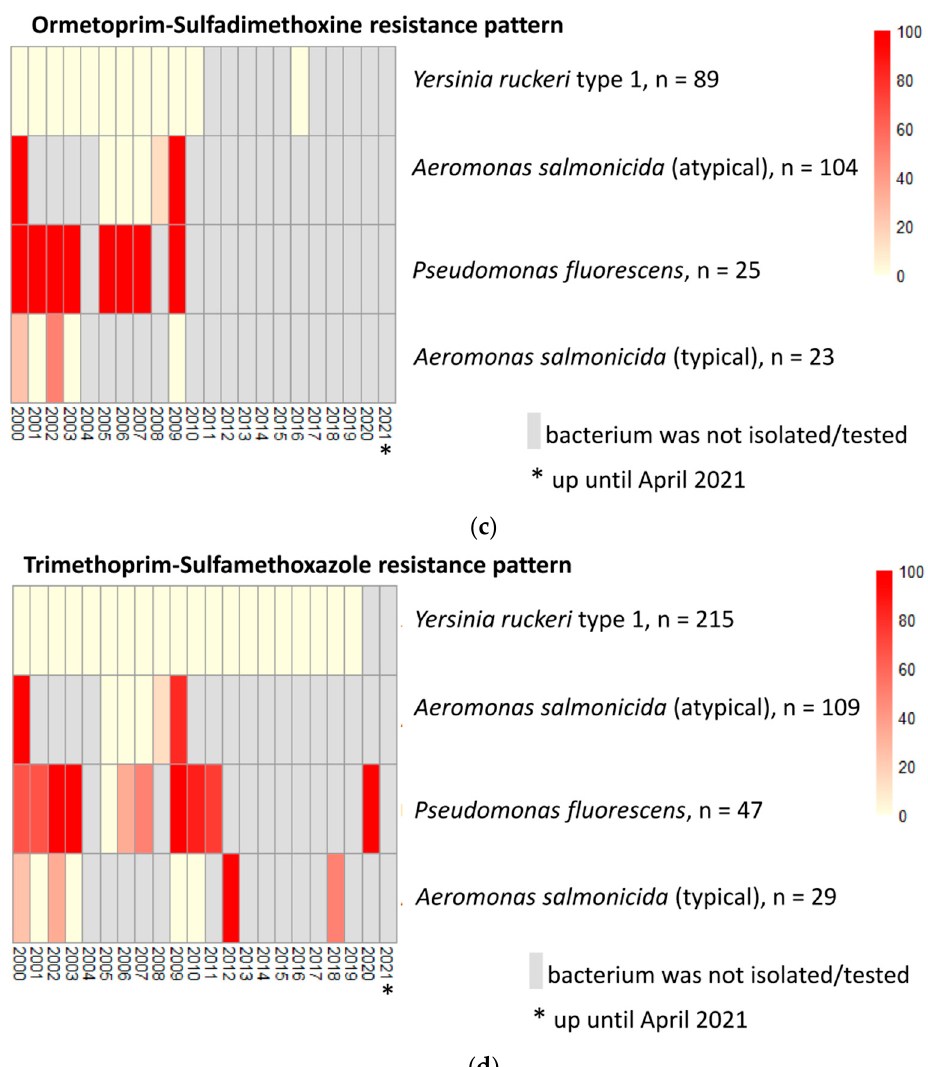
Figure 5. Heat maps show annual antimicrobial resistance trends for ( a ) florfenicol, ( b ) oxytetracycline, ( c ) ormetoprim-sulfadimethoxine, and ( d ) trimethoprim-sulfamethoxazole for the most frequently tested bacterial isolates from salmonid samples (2000–2021).